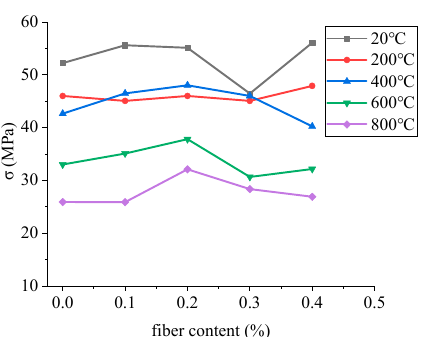
Figure 3. The variation rule between fiber content and stress peak strength.